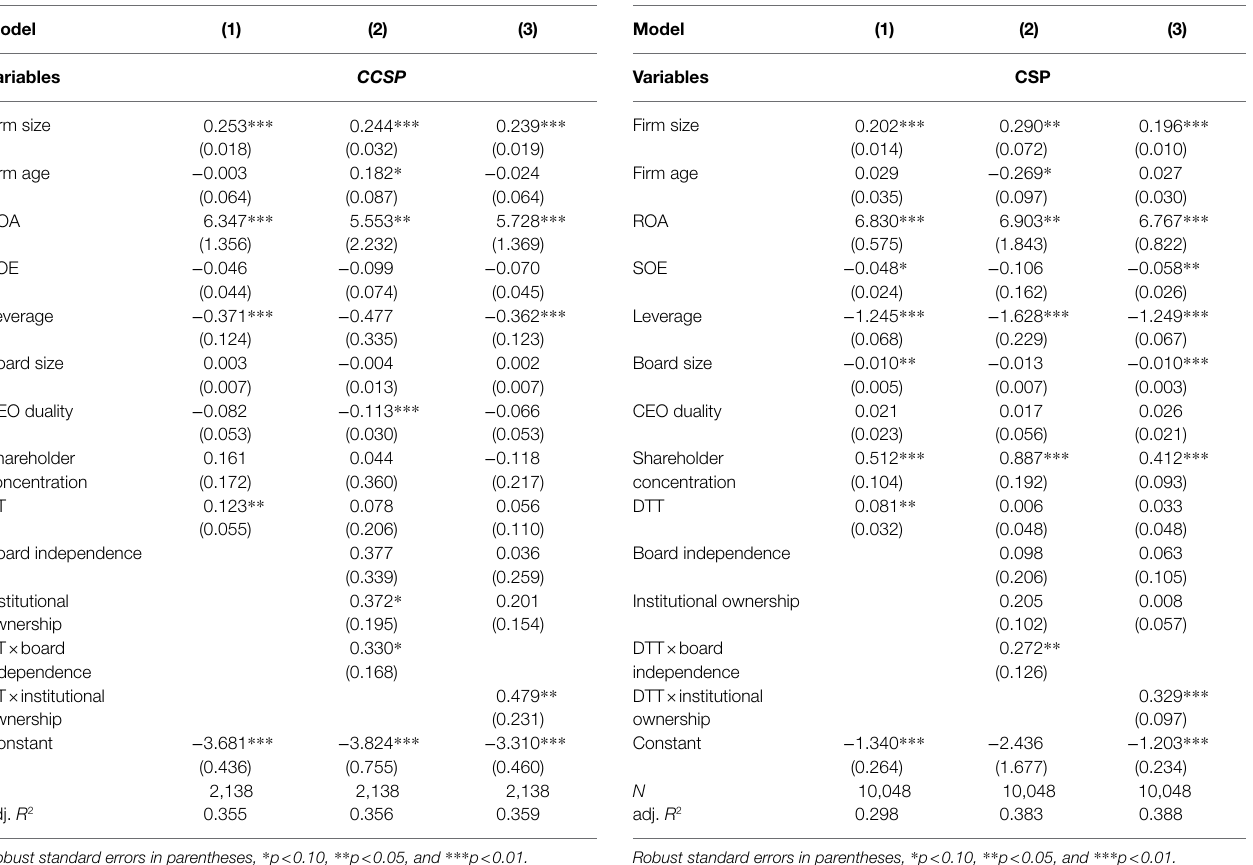
TABLE 7 | Robustness check: Alternative proxy for digital